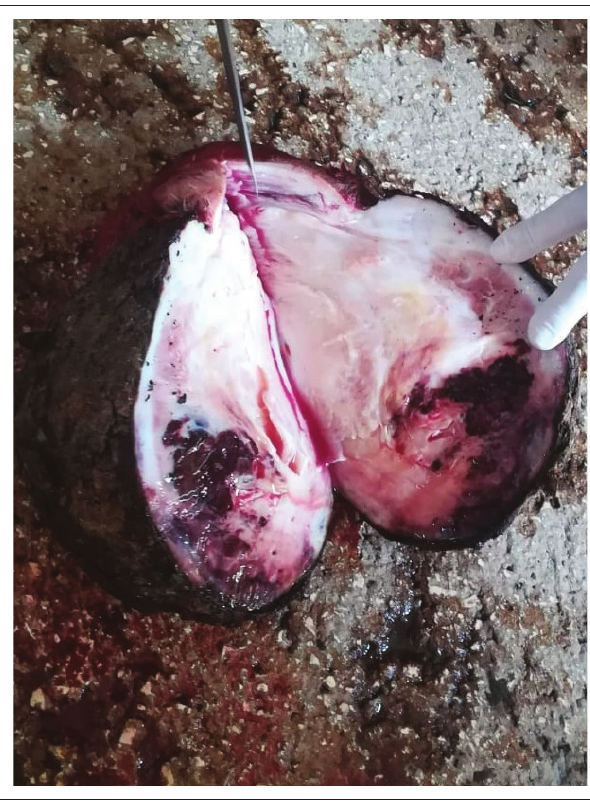
FIGURE 2: Cut section of the resected mass showing colour heterogeneity ranging from diffusely white to multifocally brownish areas and tinged with blood from haemorrhage in its central